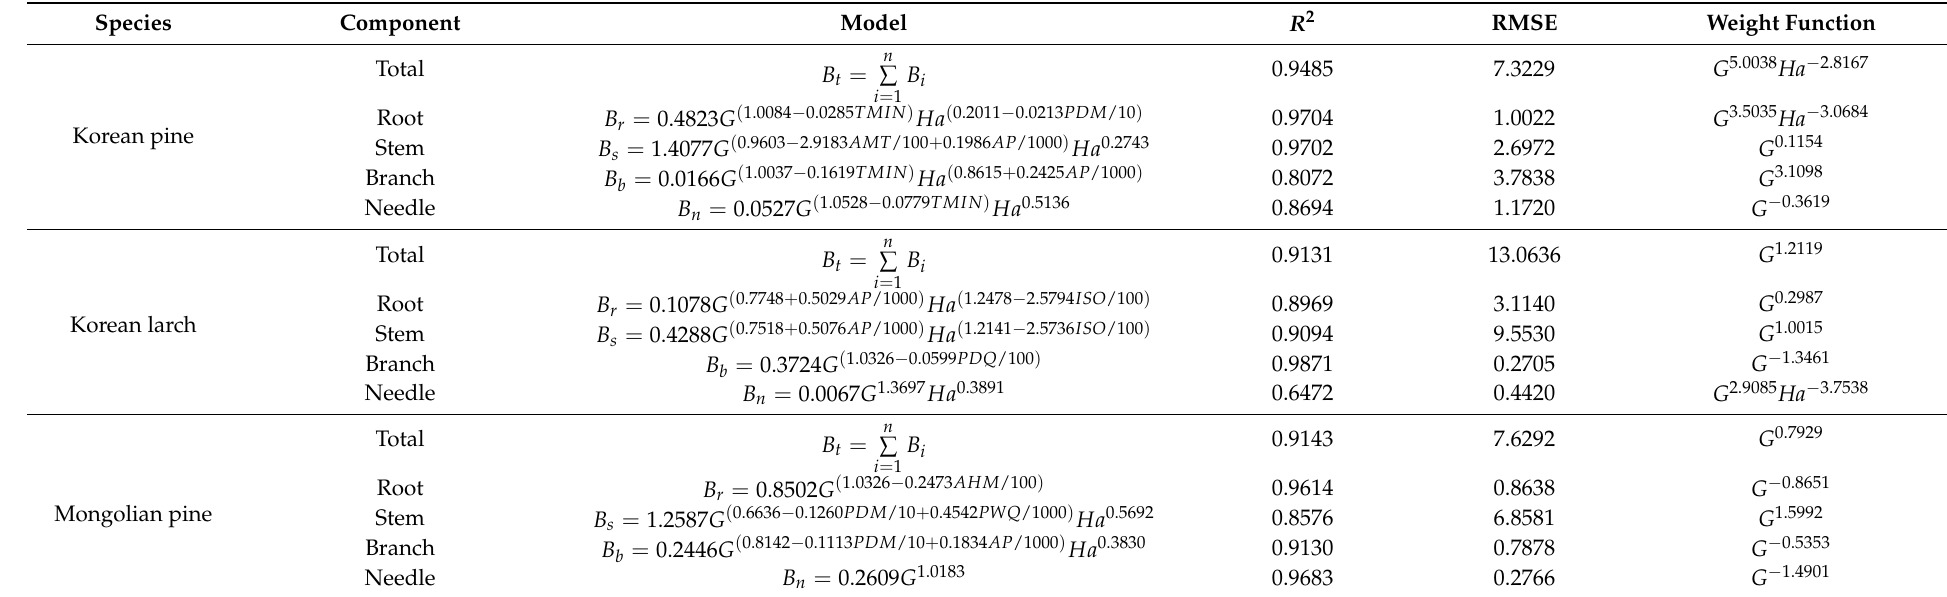
Table 4. Parameters and goodness-of-fit statistics of the CBMs and weight functions for three conifer